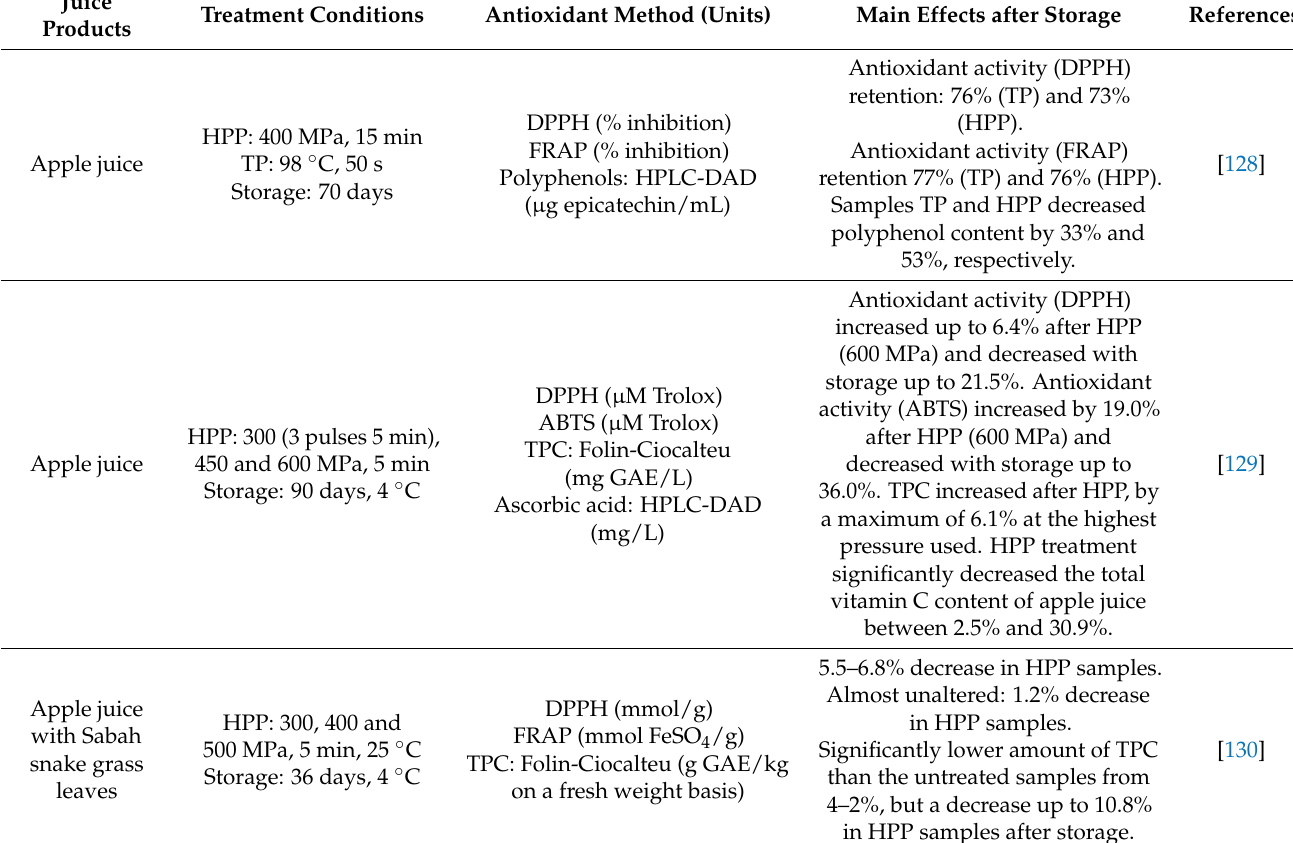
Table 2. Effect of HPP treatment and storage on the antioxidant capacity of